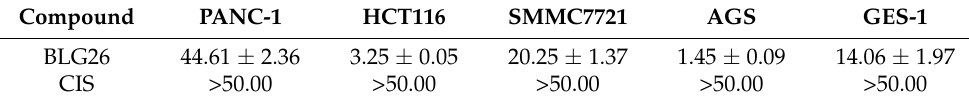
Table 1. Anti-proliferative activities (IC 50 , µ M) of BLG26 on gastrointestinal tumors for 48 h.